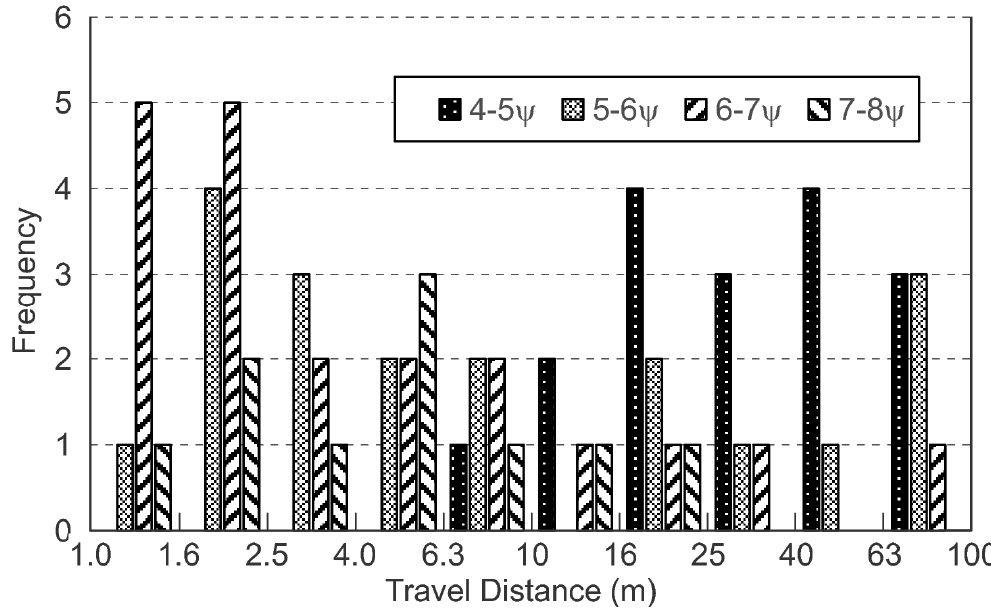
Figure 6. Histograms of log-transformed travel distances by size class for the largest flood (May 2014–July 2014) in the restoration